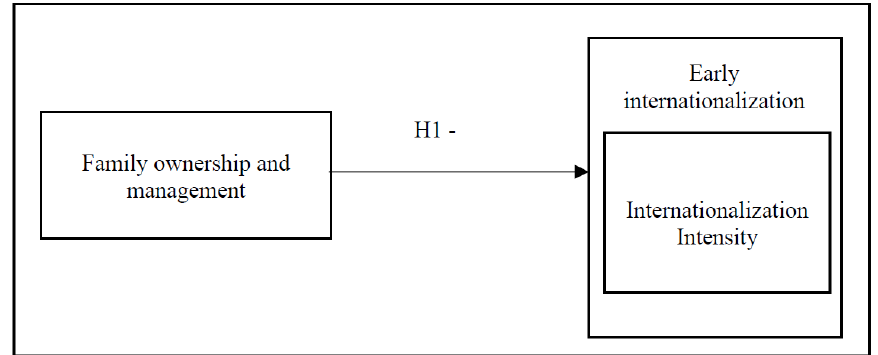
Figure 1. Research Model. Early Internationalization.